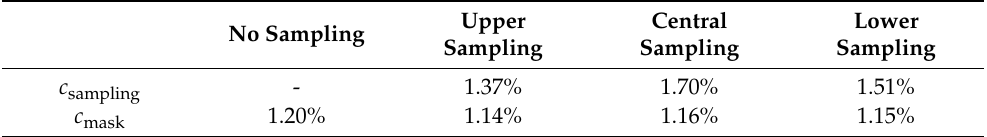
Figure 6. CO 2 concentration distribution in the symmetric section of the head in one breath cycle for different cases of air sampling. Table 3. Time-average CO 2 concentrations for different air sampling